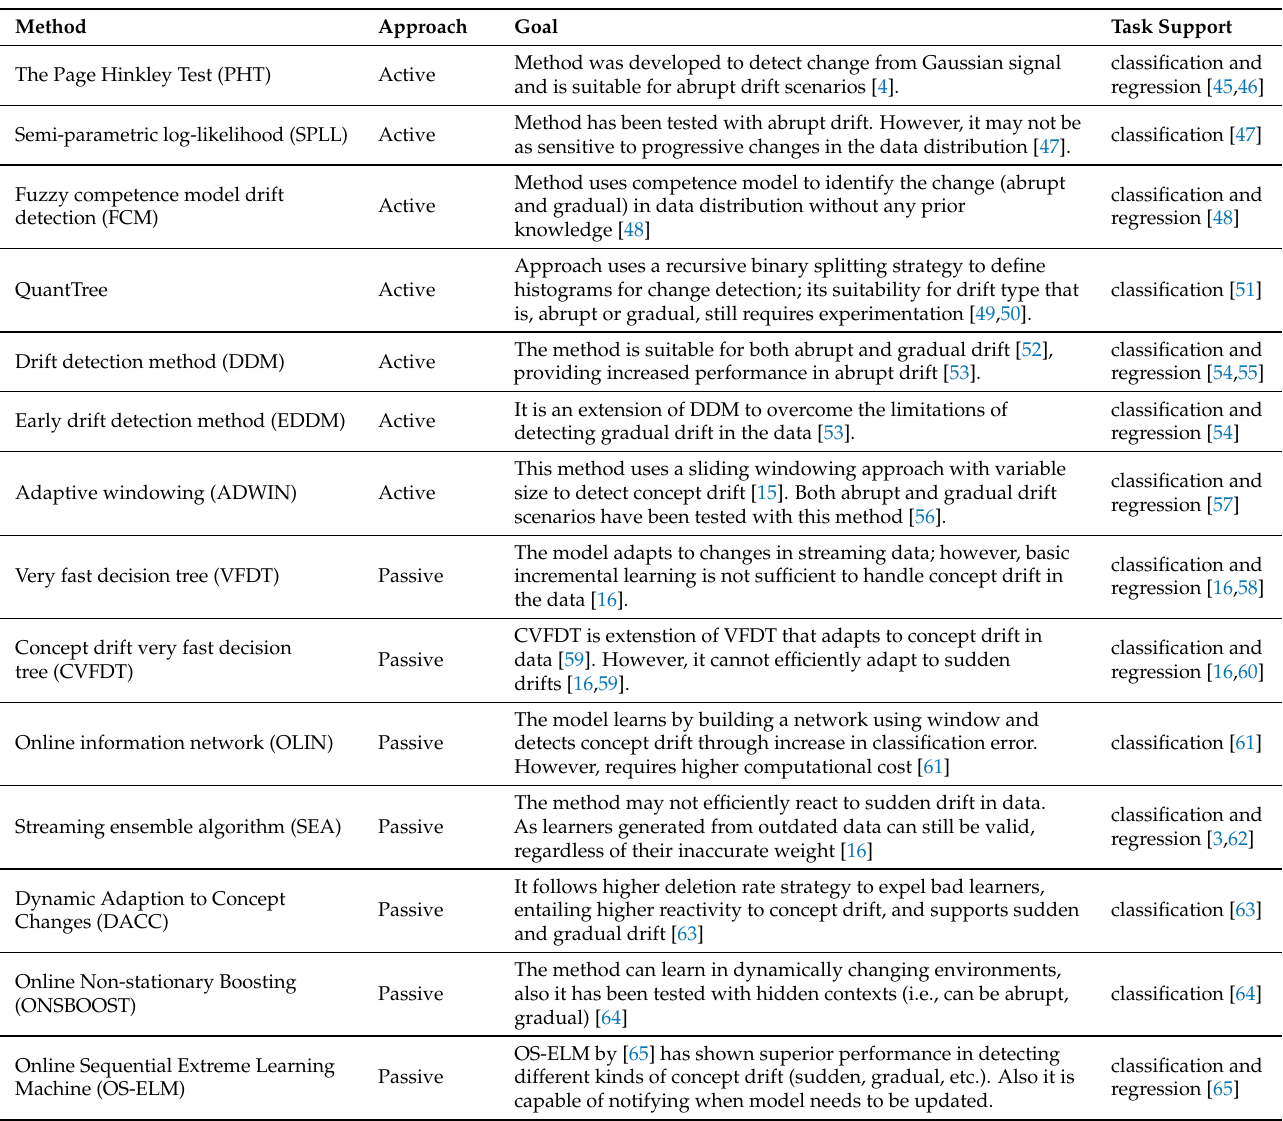
Table 1. Summary of selected concept drift methods and their